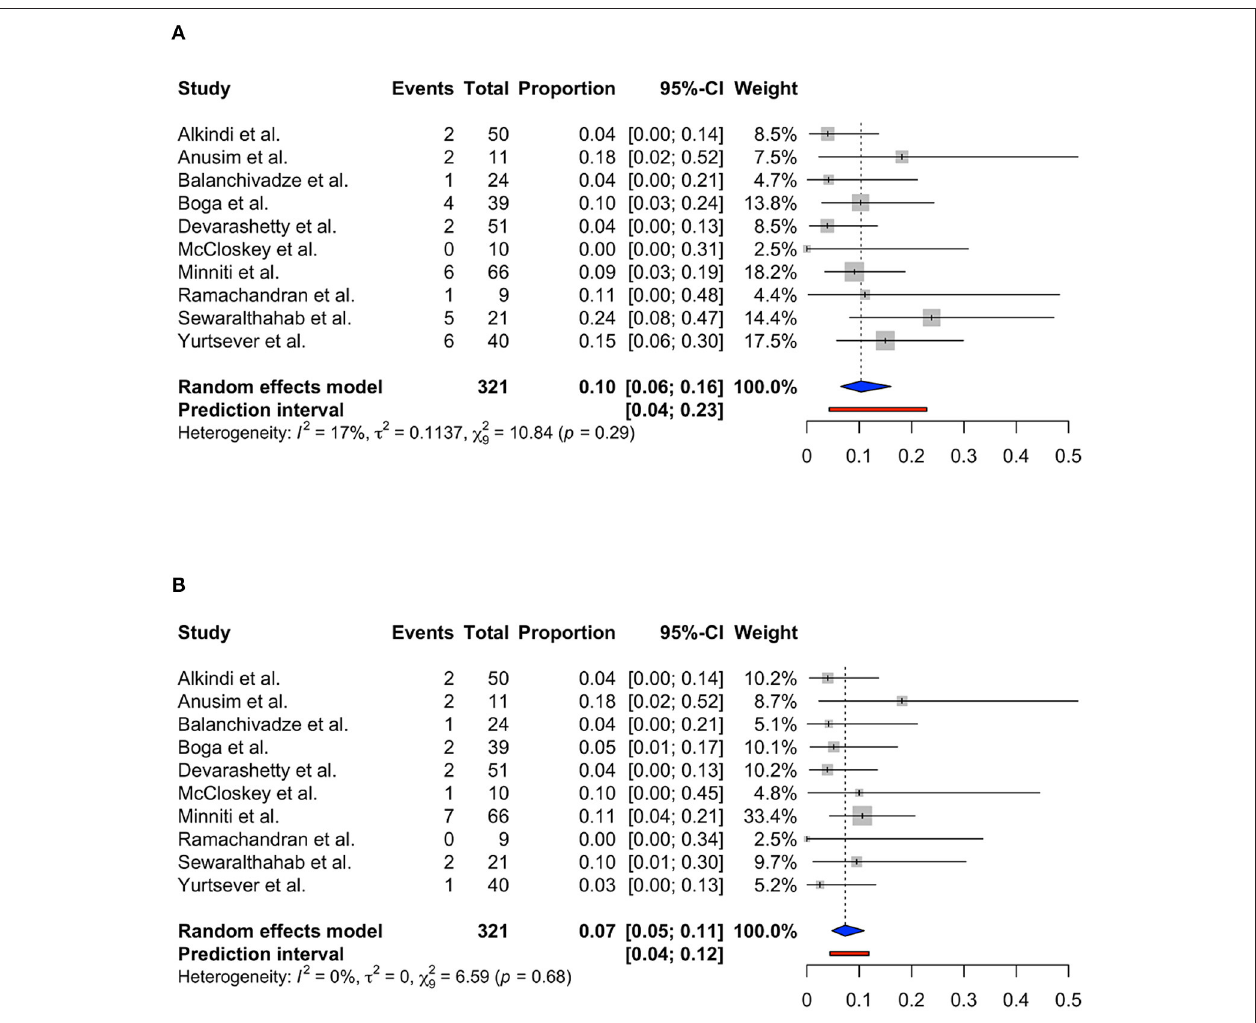
FIGURE 3 | Forest plot showing (A) ICU admission and (B) mortality due to COVID-19